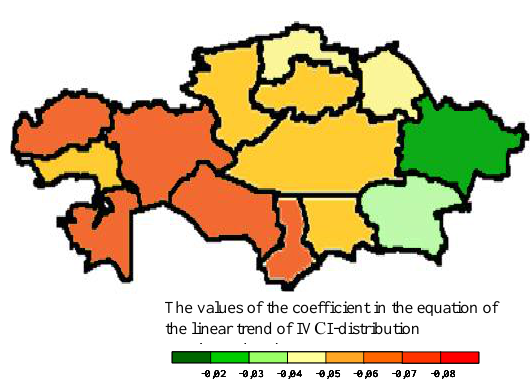
Figure 6. Zoning of the Kazakhstan territory by the values of the coefficients in linear trend equations of long-term changes of IVCI (scale of oblasts)